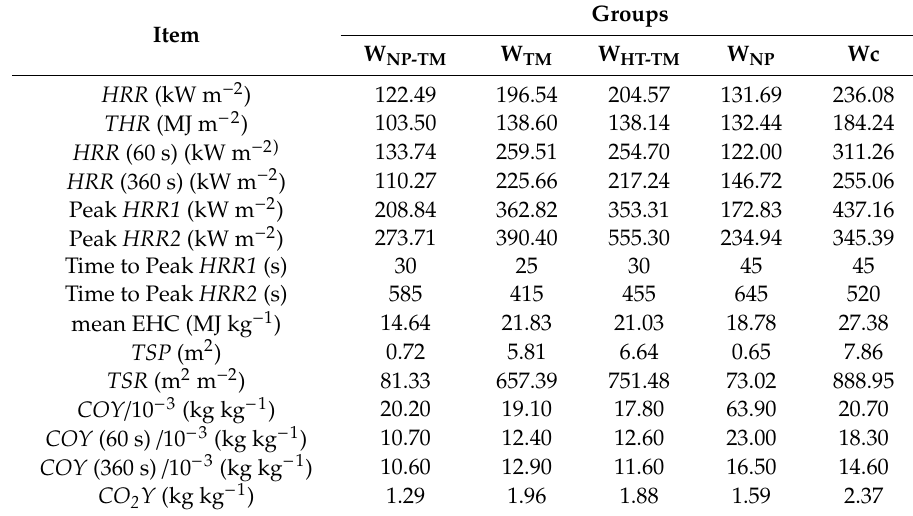
Figure 3. Heat release rate ( a ) and total heat release ( b ), generation rate of carbon monoxide ( c ), and total smoke production ( d ) of the selected samples. Table 3. Heat release and flue gas release of selected samples during cone analysis.